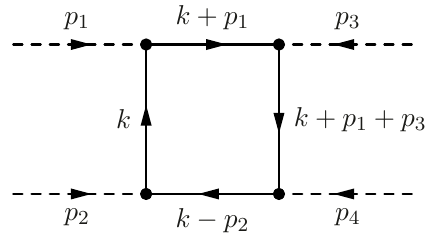
Figure 6 . Reproduction of the diagram for the loop